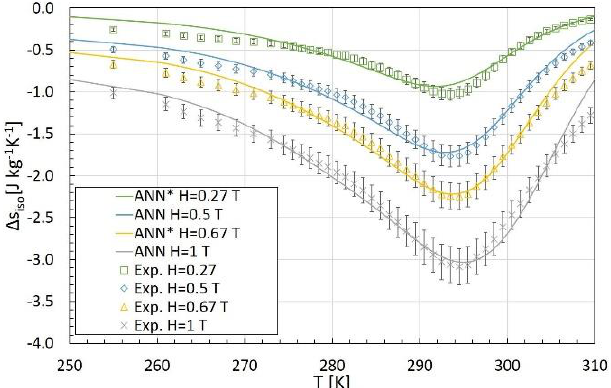
Figure 4. Comparison between the isothermal entropy changes of gadolinium at different magnetic fields calculated with the ANN approach and those calculated by direct numerical integration. The asterisk in the legend indicates an applied magnetic field not included in the training dataset.